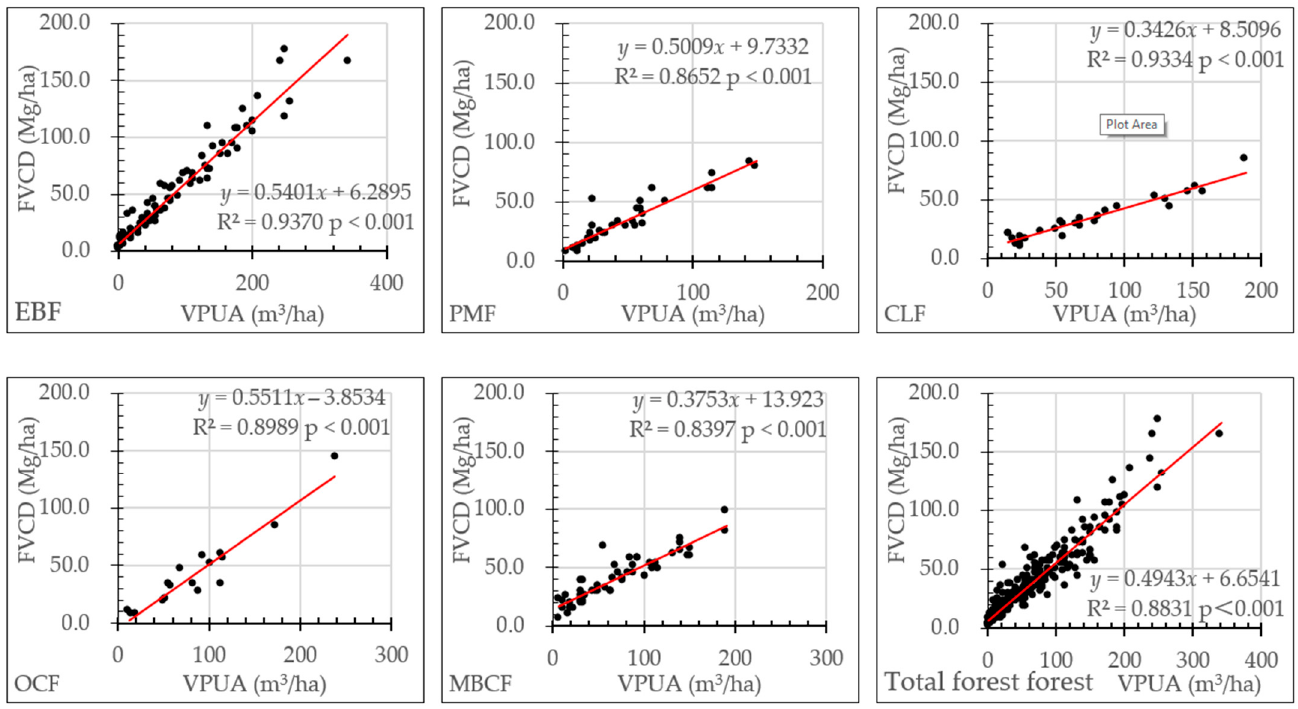
Figure 3. Models of FVCD (FVCD) and volume per unit area (VPUA) for main forest types in Jiangxi province.